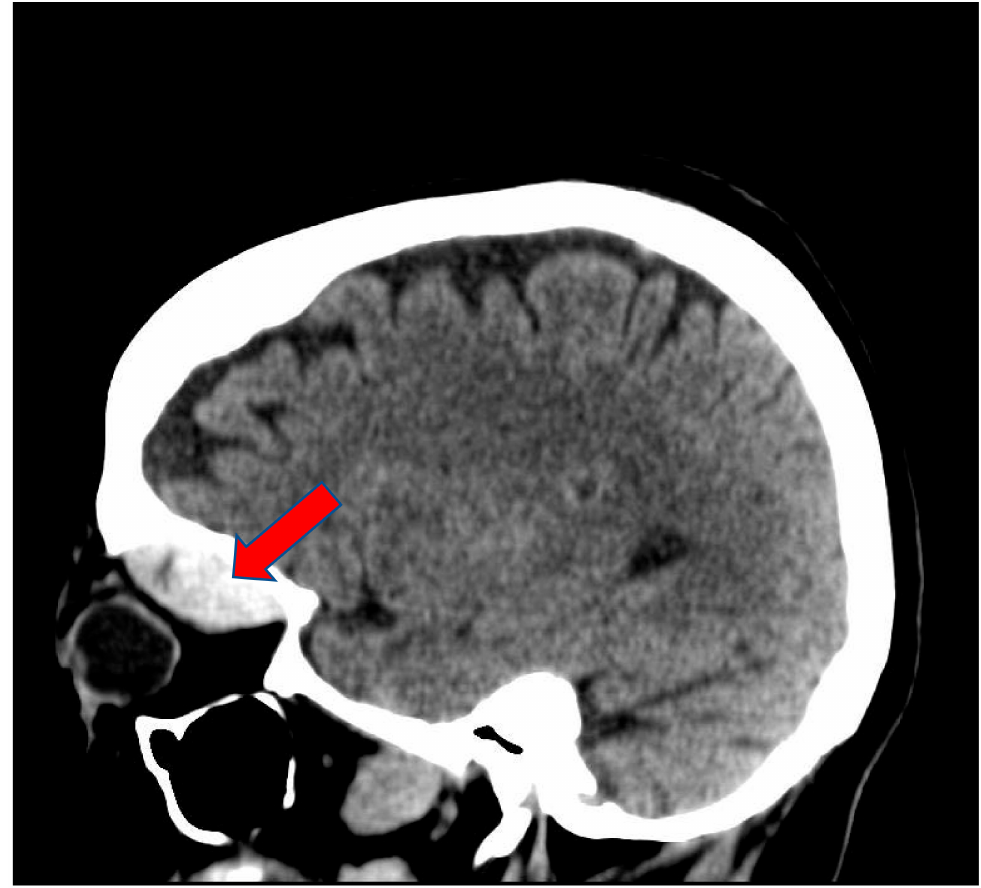
Figure 2. Sagittal view of Brain CT scan showing left soft tissue swelling with hyper dense mass in the left superior orbit measuring 3.7 × 2.9 × 1.5 cm